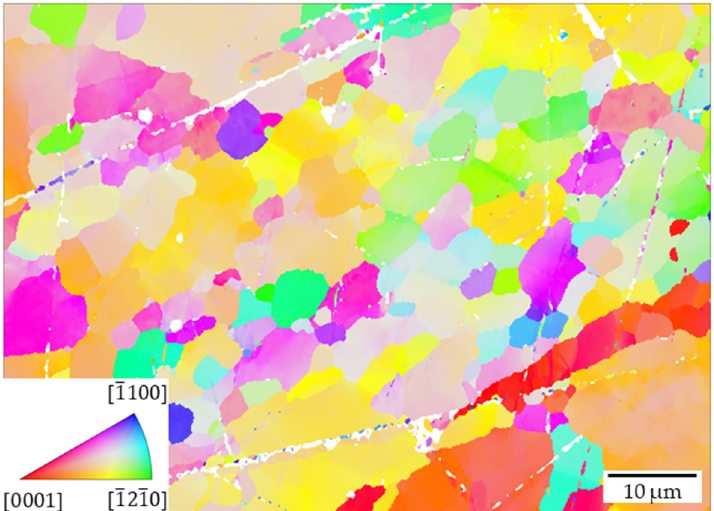
Figure 16. EBSD measurement of the transformed AZ31 magnesium alloy Point III (350 °C, 0.01 s − 1 ): area into which the structure is continuously dynamically recrystallized, typical CDRX.